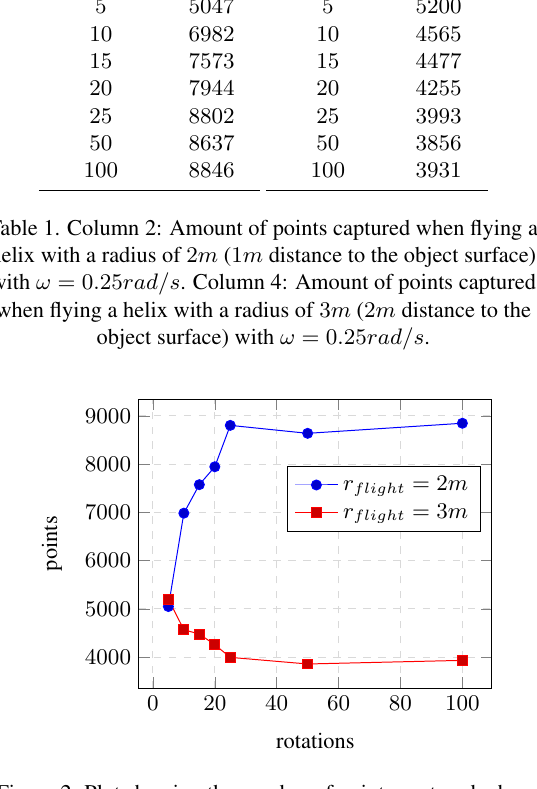
Figure 2. Plot showing the number of points captured when flying a helix with different radius and rotations at ω = 0 . 25 rad/s